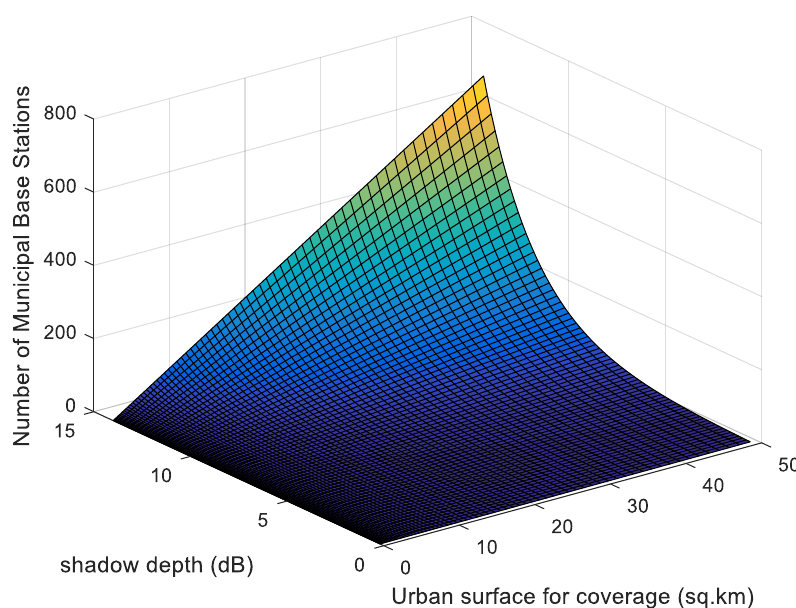
Figure 3. Number of municipal base stations required for a 5G-enabled coverage of an urban obstacle-dense propagation topology.